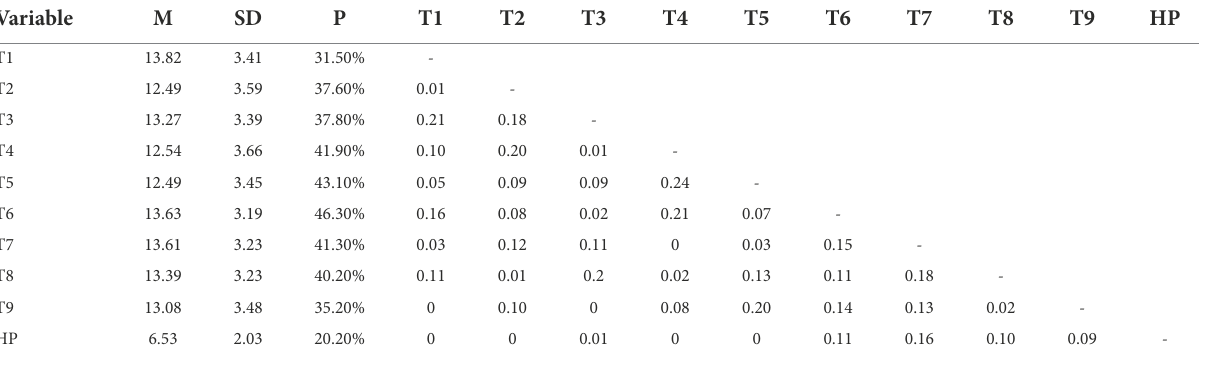
TABLE 1 Descriptive data, predictability, and network relationships. Variable